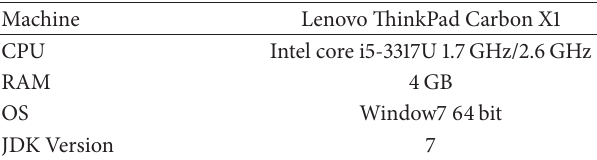
Table 3: Details of testing